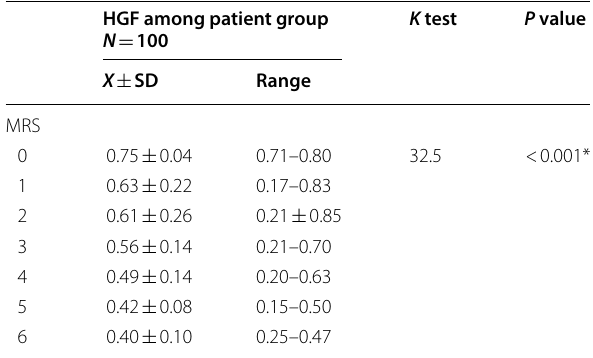
Table 14 Relationship between HGF and MRS among patient group